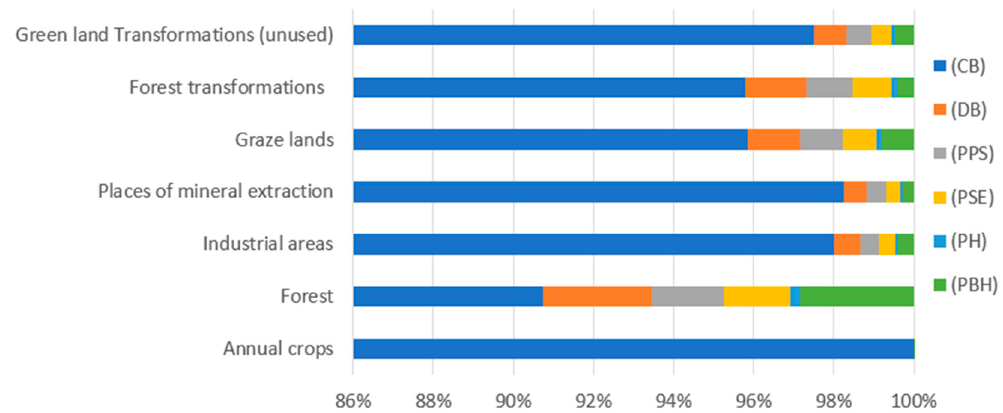
Figure 13. Results of environmental impact characterization for the category of land use (species.yr).